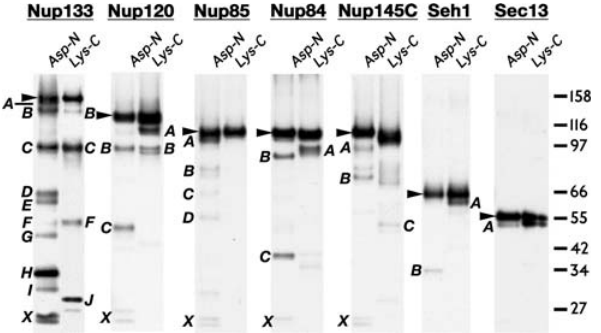
Figure 2. Proteolytic Domain Map of the Yeast Nup84 Subcomplex Proteins Immunoblots of limited proteolysis digests for Protein A-tagged versions of each of the seven nups in the yNup84 subcomplex. Each protein is detected via its carboxyl-terminal tag; thus, all the fragments visualized are amino-terminal truncations (except for the full length proteins, which are indicated by arrowheads). The fragments of the Asp-N and Lys-C protease digests depicted in Figure 2 are labeled with letters (A, B, C ... ) that correspond to those in Table 2, and the terminal Protein A fragments are labeled with an X (the Protein A tag is resistant to proteolysis). The sizes of marker proteins are indicated in kilodaltons (kDa) to the right of the gel. DOI: 10.1371/journal.pbio.0020380.g002